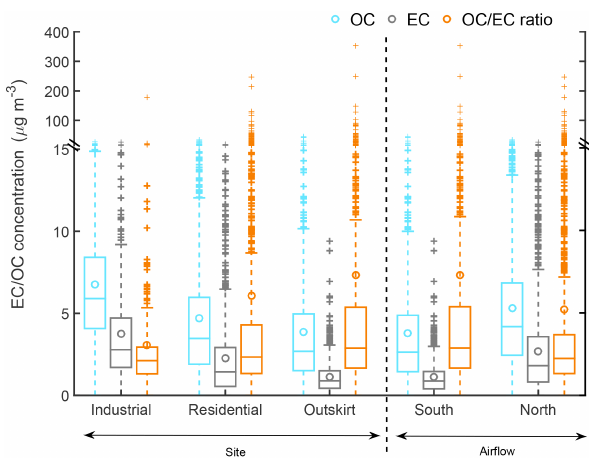
Figure 2. Observed OC and EC concentrations (µgm − 3 ) separated by site types and air mass source region according to Table 1 and Fig. 1b. Box-and-whisker plots show median and quartile values; averages are shown as circles and outliers as crosses.